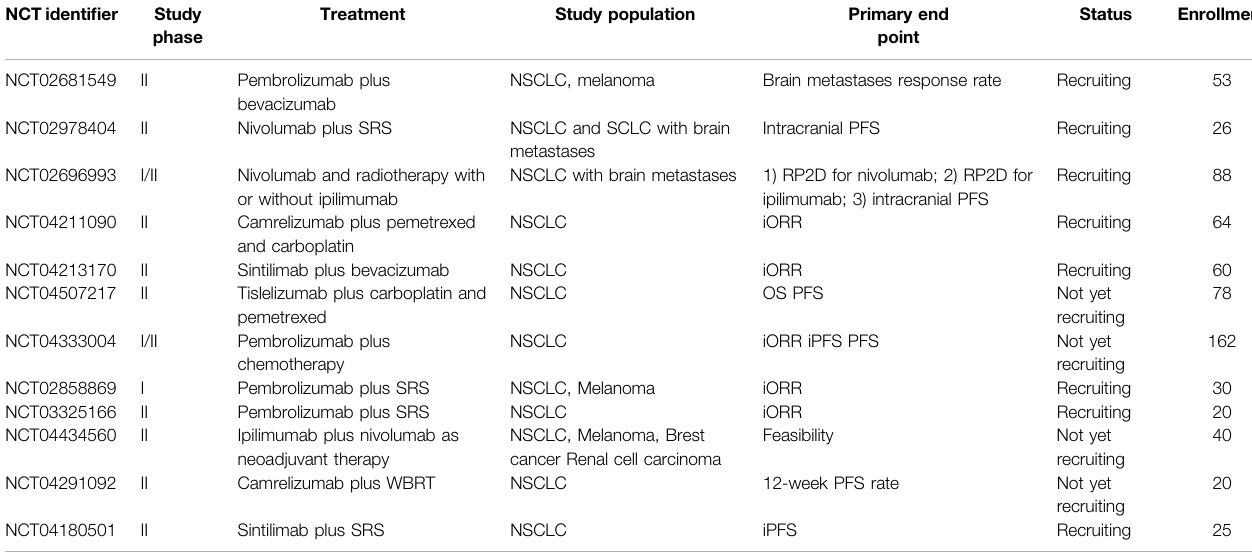
TABLE 3 | Selected ongoing clinical trials of immunotherapy in NSCLC patients with brain metastases. NCT identi fi